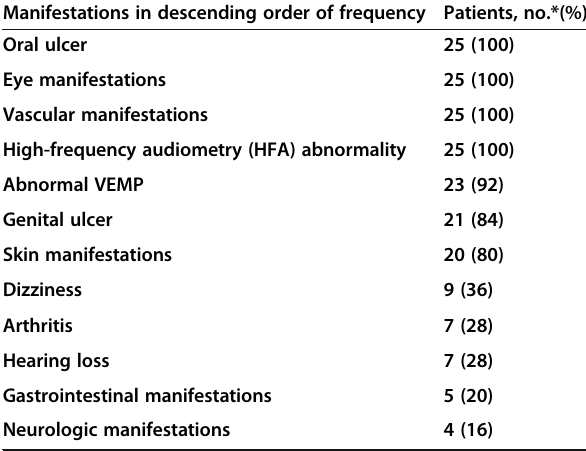
Table 2 Clinical characteristics and VEMP and PTA abnormalities of BD